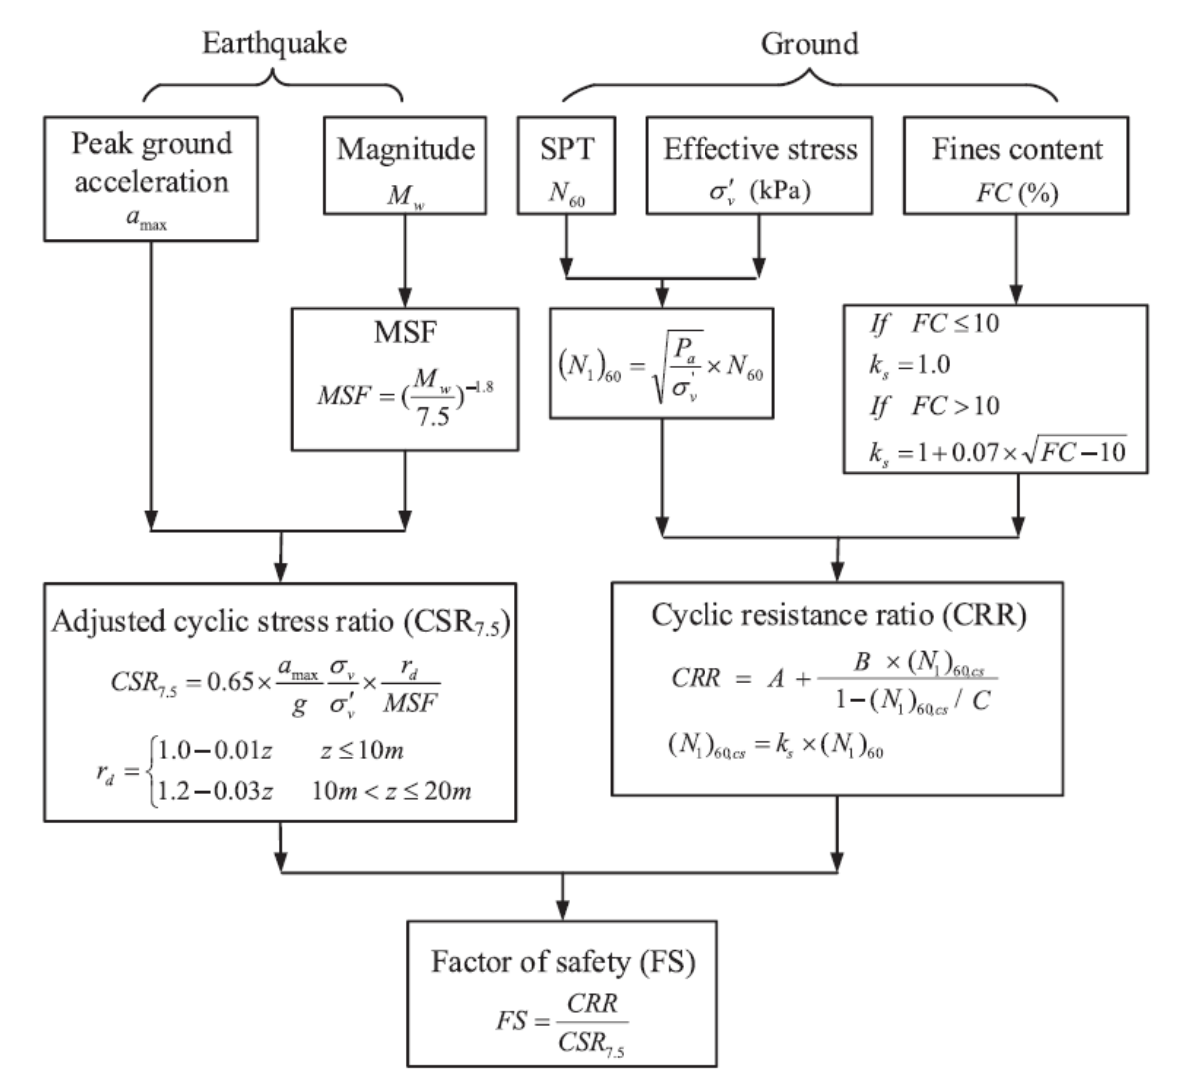
Figure 3. Analytical procedure of the HBF method [1].